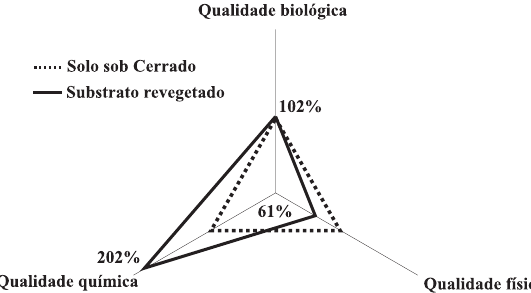
Figura 2. Diagrama comparativo da qualidade do substrato revegetado em relação ao solo sob